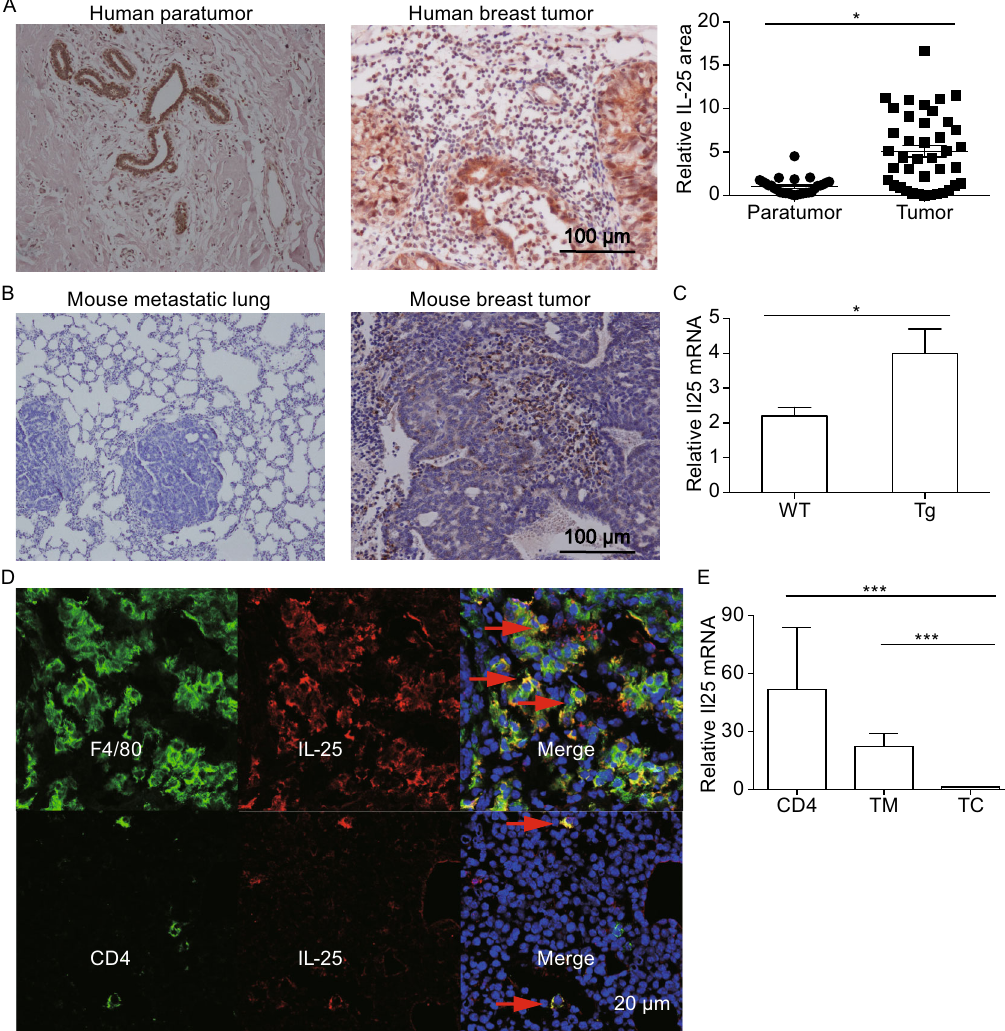
Figure 1. Macrophages and CD4 cells expressed IL-25 inside mammary adenocarcinoma. (A) Image Pro Plus characterized IHC-staining of IL-25 (×10 magni fi cation) in human breast paratumor and carcinoma, and the IL-25+ cells through counting the relative positive area. (B) IHC-staining of IL-25 in mouse breast carcinoma and metastatic lung tissues of the MMTV-PyMT transgenic mice. (C) The relative mRNA level of Il25 in breast tissues isolated from wide type and the MMTV- PyMT mice (14 weeks old)